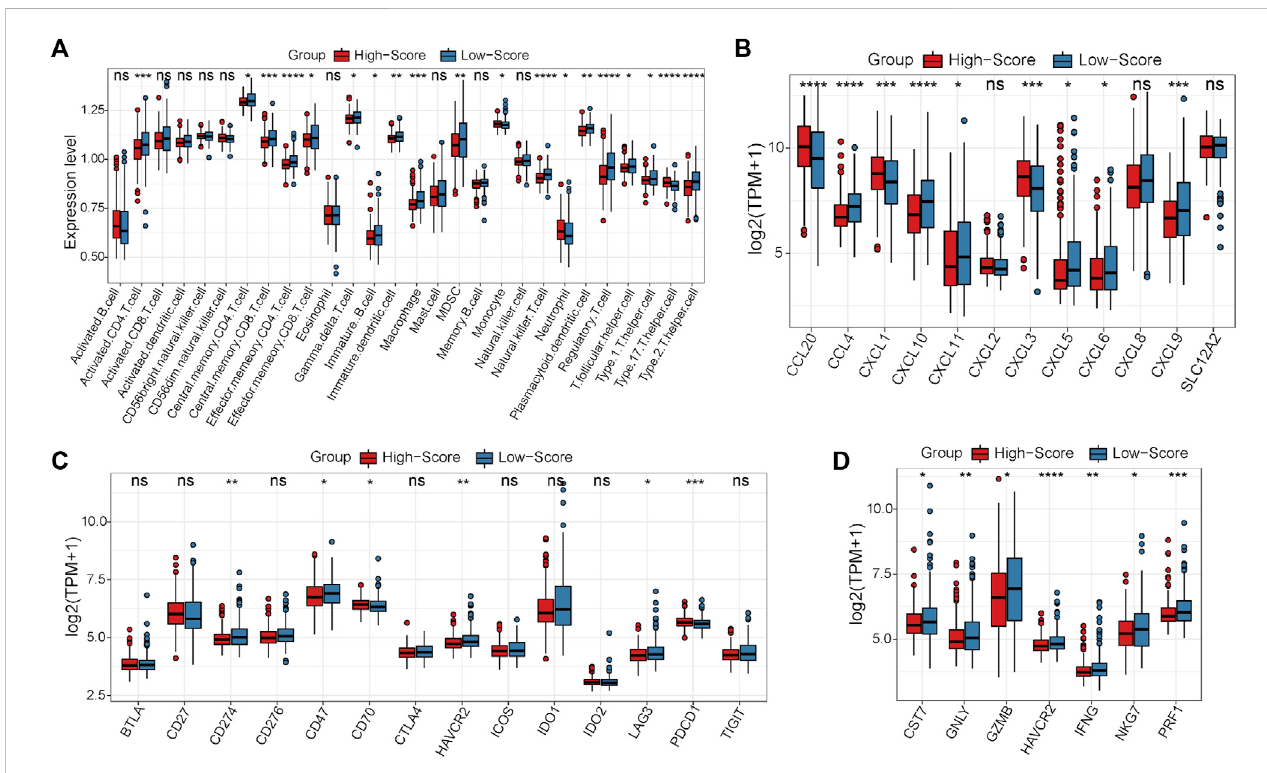
FIGURE 7 Differentialanalysesbetweenthehigh-andlow-scoregroupsseparatedbytheMSS-relatedriskscoreintheGEO-CRCcohort. (A) Theexpressionlevels of the 28 immune cell types in the two groups were visualized by boxplot. (B – D) The expression status of classical chemokines (B) , immune checkpoint molecules (C) and cytotoxic molecules (D) between the two risk groups. * p < 0.05, ** p < 0.01, *** p < 0.001, **** p < 0.0001, ns, not signi fi